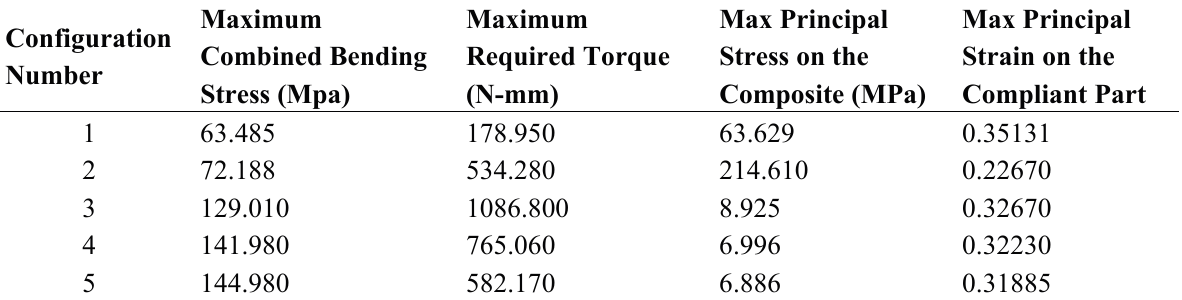
Table 7. Results summary of structural analyses of all design